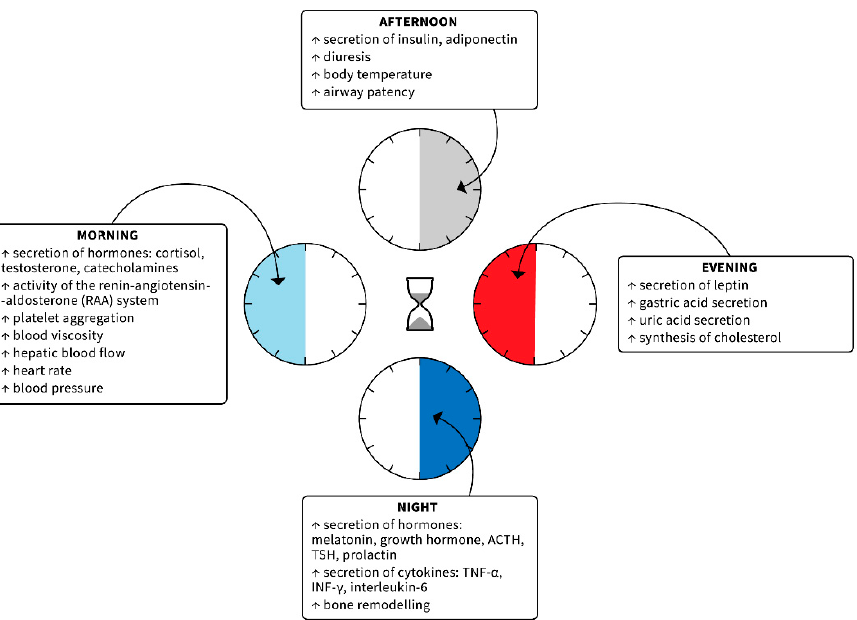
Figure 1. Physiological and pathophysiological phenomena that follow a circadian rhythm [1–